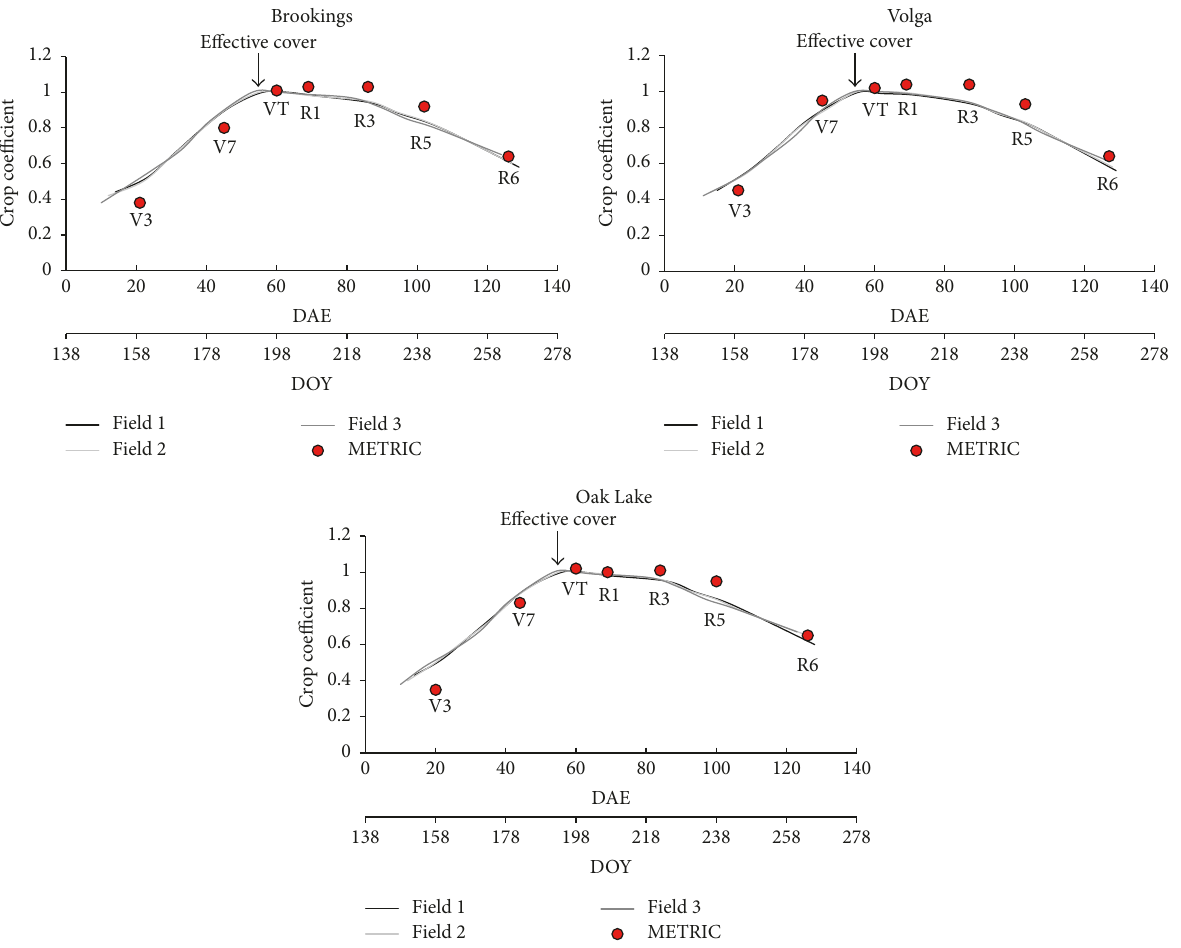
Figure 6: Crop coefficient curves based on the alfalfa reference crop coefficient in three fields at the Brookings, Volga, and Oak Lake sites. The red circles indicate the average 𝐾 𝑐 (ET F) values derived from the METRIC model. r